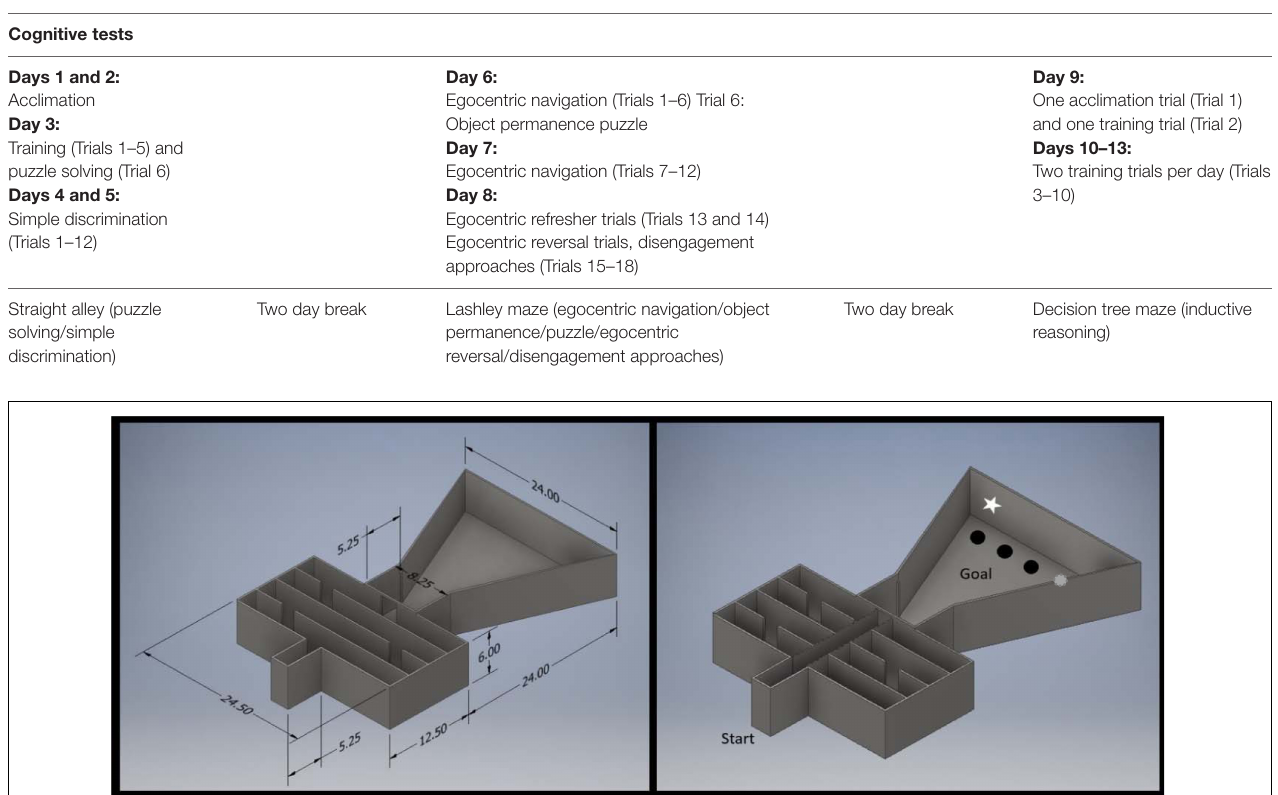
repeated for a total of five trials with a 6–10 min ITI for